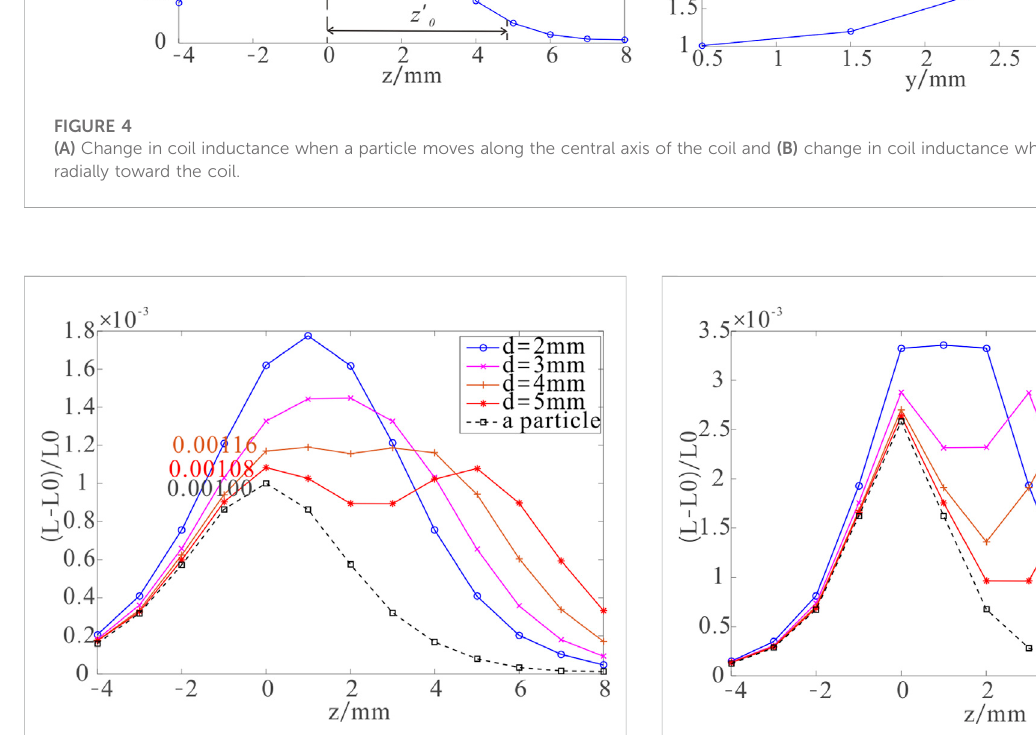
FIGURE 6 Coil output signals when two particles deviating from the central axis by 3 mm with a distance of d pass through the